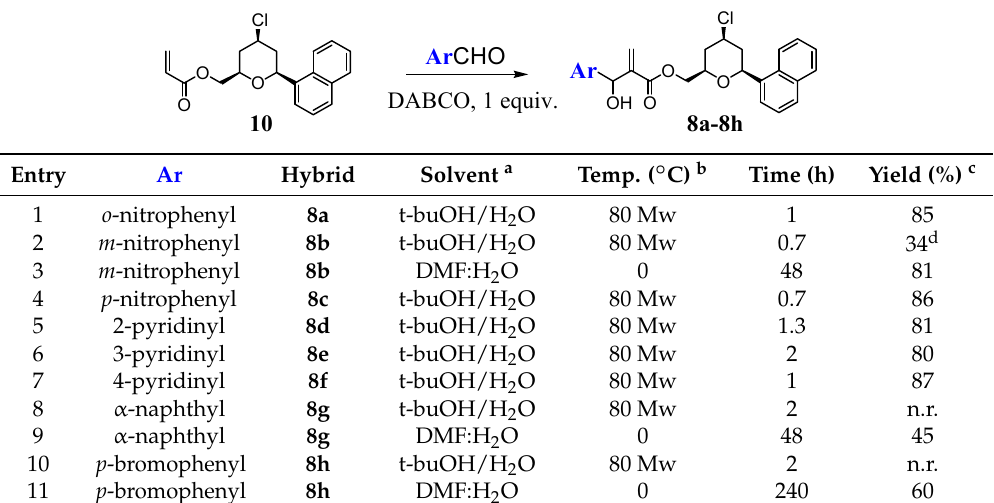
Table 1. Conditions and yields in the synthesis of new hybrids 8a – 8h .